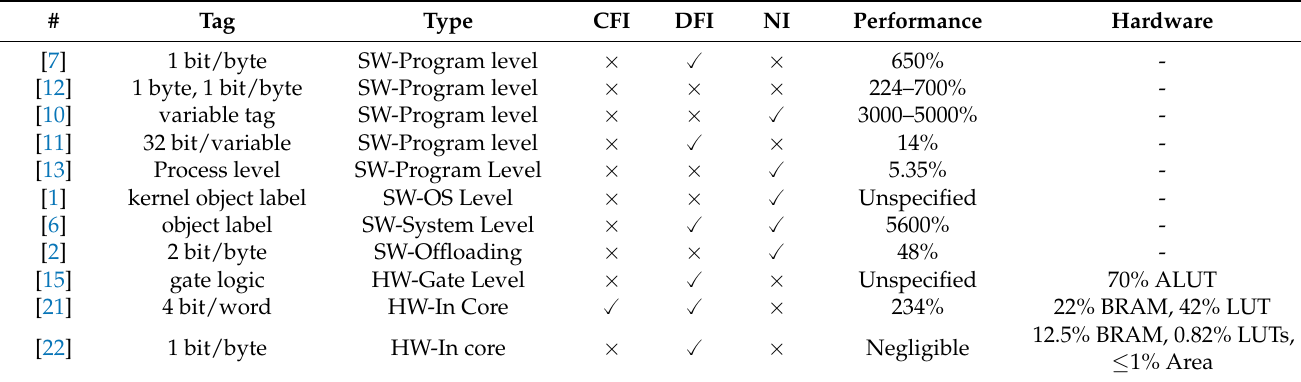
Table 1. Details of dynamic information flow tracking techniques. CFI, DFI and NI are abbreviations of control-flow integrity, data-flow integrity and new infrastructure,